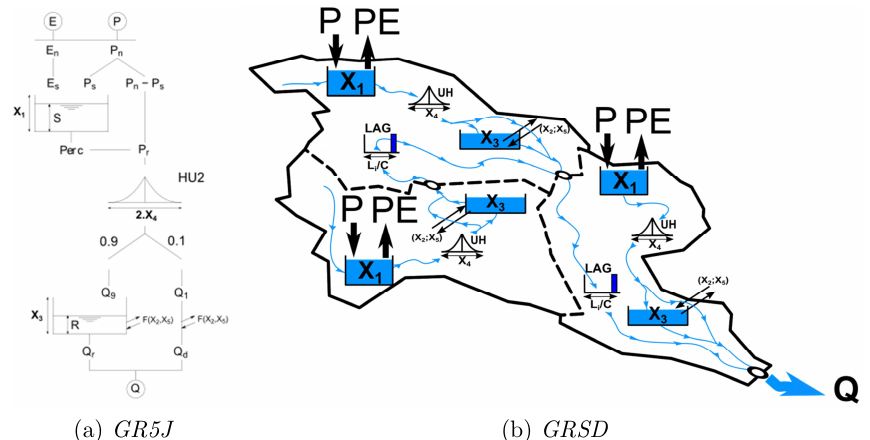
Figure 2. Schematic representation of the GR5J and GRSD semi-distributed model (from Lobligeois et al., 2014).